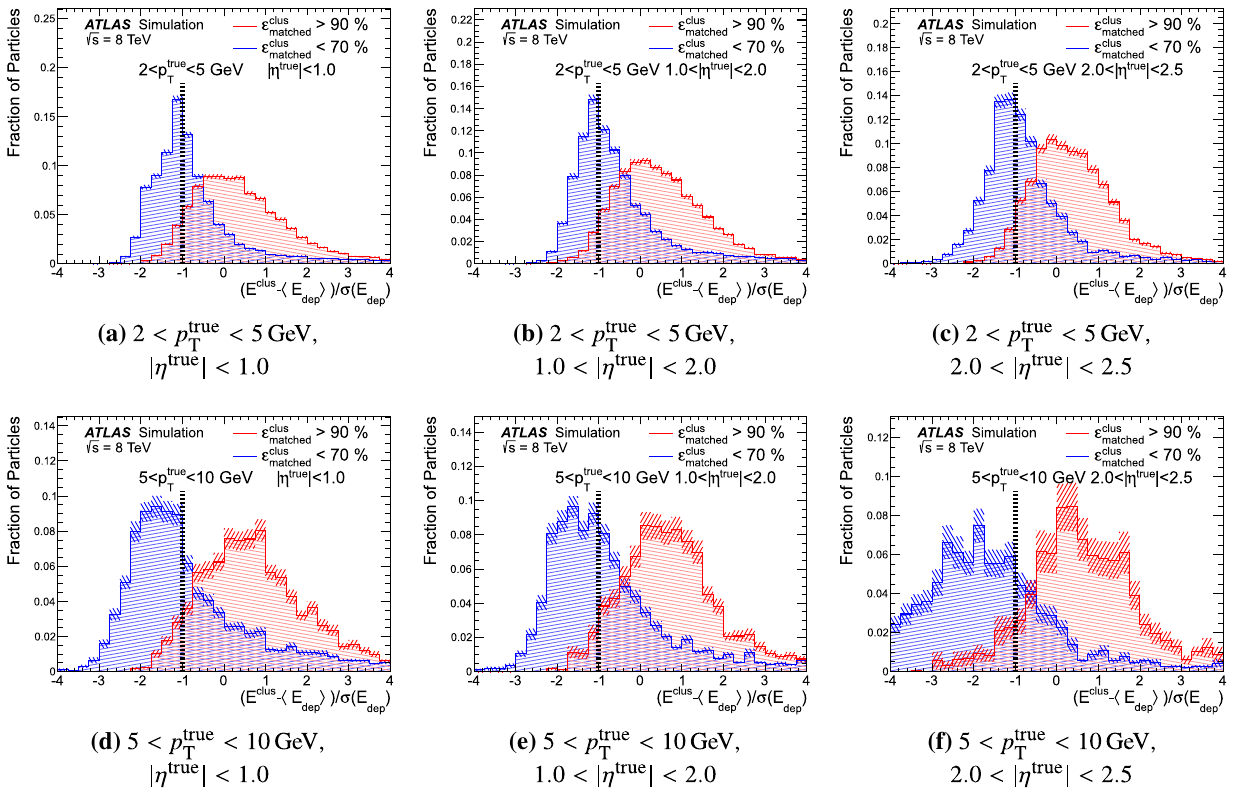
> 90%; considered ( 93 , 95 , 95 , 94 , 95 , 91 ) %ofthetimewhen ε clus matched while additional topo-clusters are considered ( 49 , 39 , 46 , 56 , 52 , 60 ) % < 70%.Thedataaretakenfromadijetsample ofthetimewhen ε clus matched < 500GeV and the statistical uncer- without pile-up with 20 < p lead T tainties on the number of MC simulated events are shown as a hatched